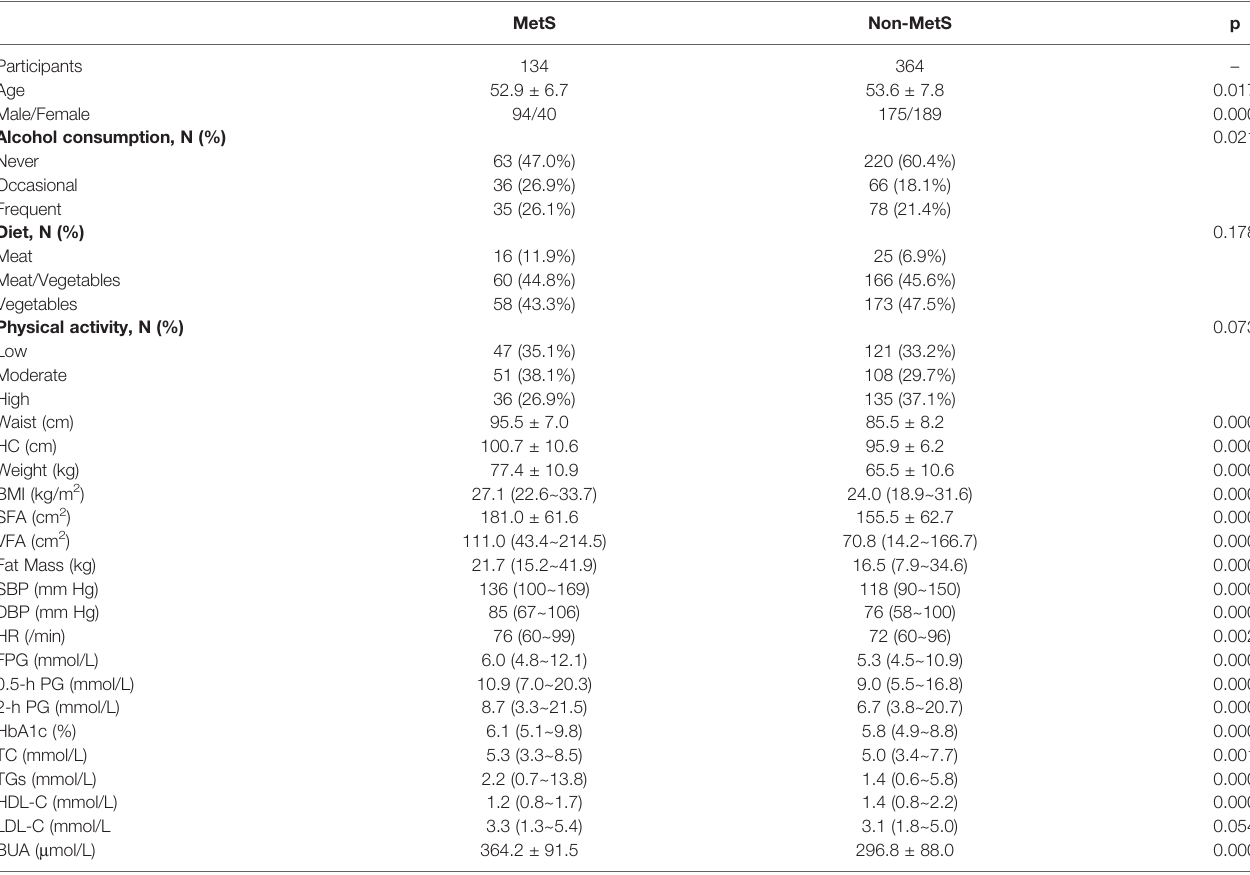
TABLE 1 | General